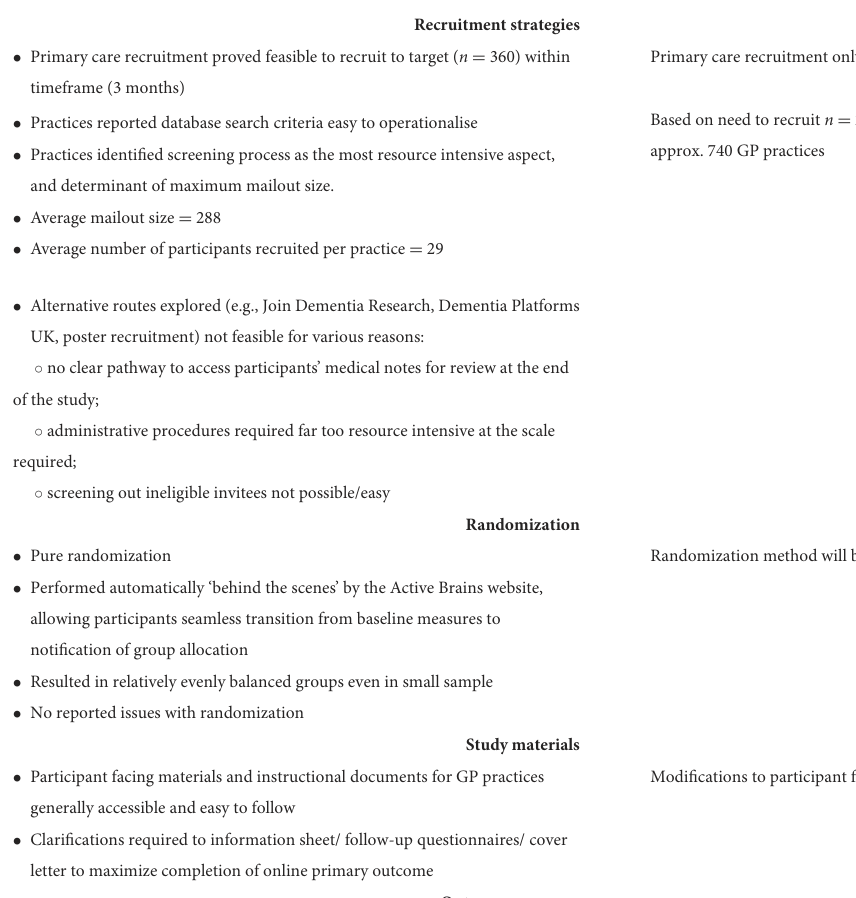
TABLE 8 Acceptability of study processes - key findings and implications for